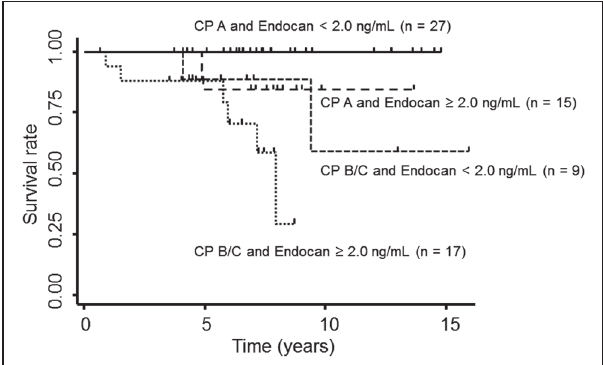
Figure 2) Kaplan-Meier survival analysis illustrating the different survival rates among the patient groups divided according to serum endocan level and Child-Pugh (CP) grade (P=0.002 [log rank test])